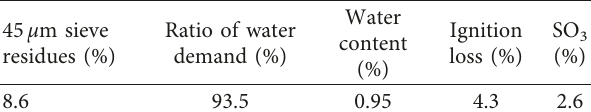
Table 2: Test items and results of fly ash.